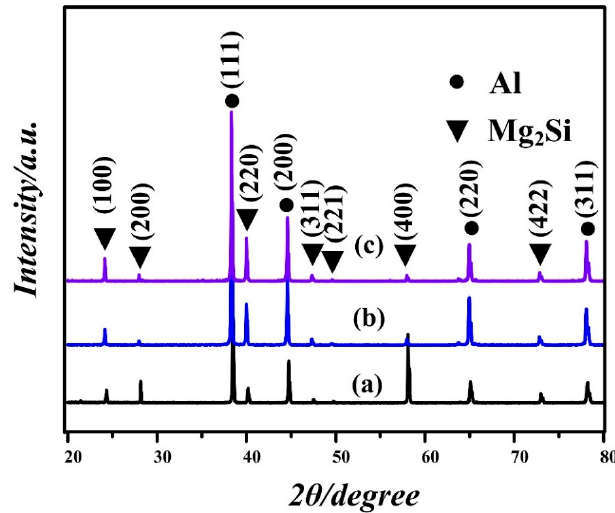
Figure 1. XRD patterns for Al-20Mg 2 Si alloy without and with various Li and Sb contents: ( a ) 0; ( b ) 0.2; and ( c ) 0.5 wt.% Li ‐ Sb.